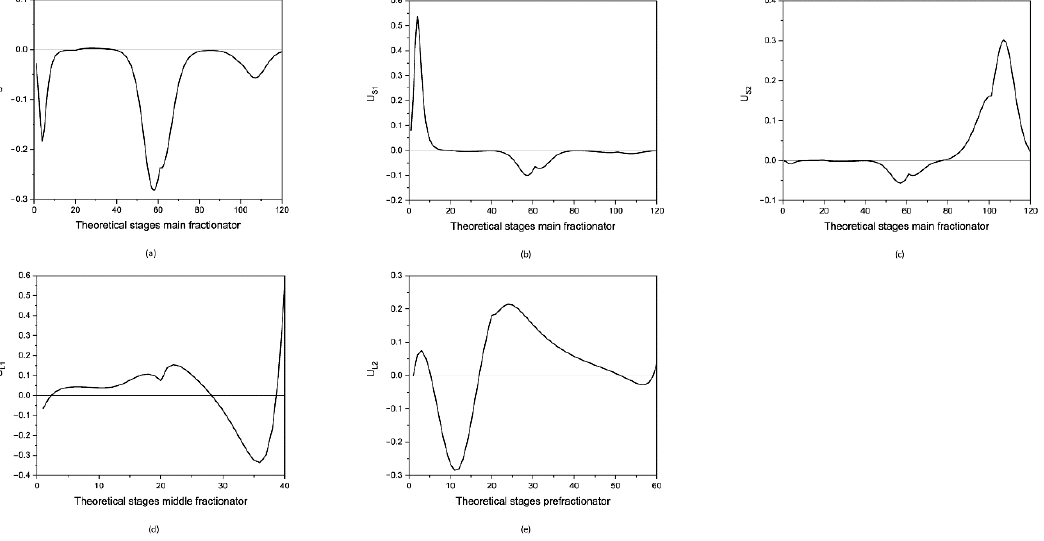
Figure 6. SVD analysis for mixture 3: ( a ) distillate, ( b ) side draw 1, ( c ) side draw 2, ( d ) liquid split 1, and ( e ) liquid split 2. Table 3. Selected temperature stages for temperature control of the respective manipulated